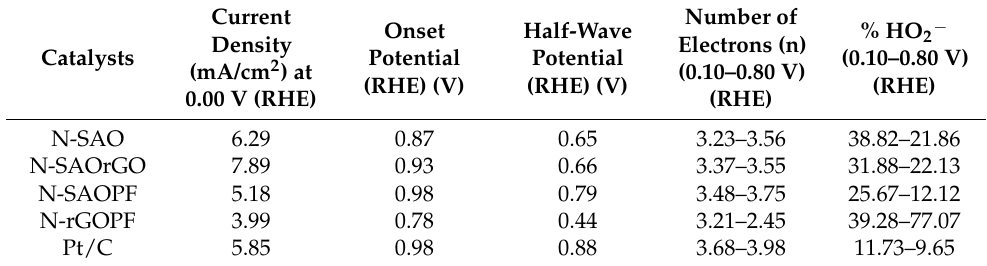
Figure 4. ( A ) Comparison of cyclic voltammetry plots of N-SAO, N-SAOrGO, N-SAOPF, N-rGOPF and Pt/C catalysts at a scan rate of 10 mVs − 1 in oxygen saturated 0.10 M KOH solution. Rotating ring disc voltammograms of ( B ) ring current and ( C ) disc current of N-SAO, N-SAOrGO, N-SAOPF, N-rGOPF and Pt/C electrodes in oxygen saturated 0.1M KOH at 2000 rpm at a scan rate of 10 mV/s. ( D ) Tafel plots of the prepared catalysts: N-SAO, N-SAOrGO, N-SAOPF, N-rGOPF and Pt/C. ( E ) Number of electrons and ( F ) percentage peroxide of N-SAO, N-SAOrGO, N-SAOPF, N-rGOPF and Pt/C electrodes at various potential calculated according to Rotating Ring Disc Electrode (RRDE) data. Table 3. Electrochemical properties of the N-doped SAO and composites of SAO